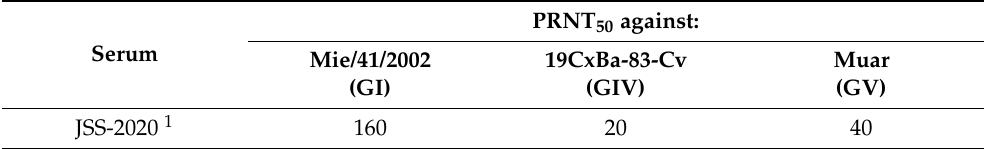
Table 2. Neutralization titers (PRNT 50 ) in serum of mice vaccinated with formalin-inactivated JE vaccine against JEV strains Mie/41/2002, 19CxBa-83-Cv, and Muar. PRNT 50 against: Serum (GI)